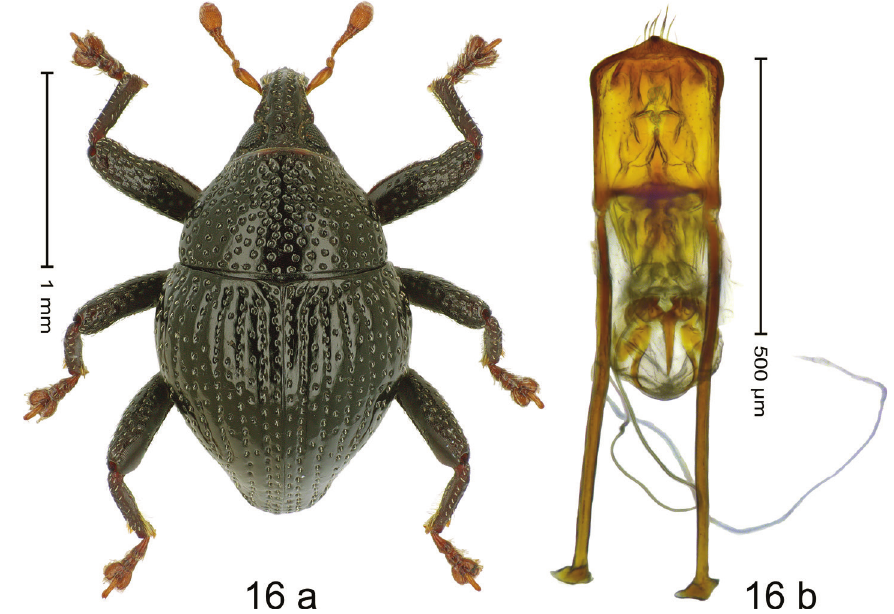
Figure 16. Trigonopterus pomberimbensis sp. nov., holotype a habitus b penis.